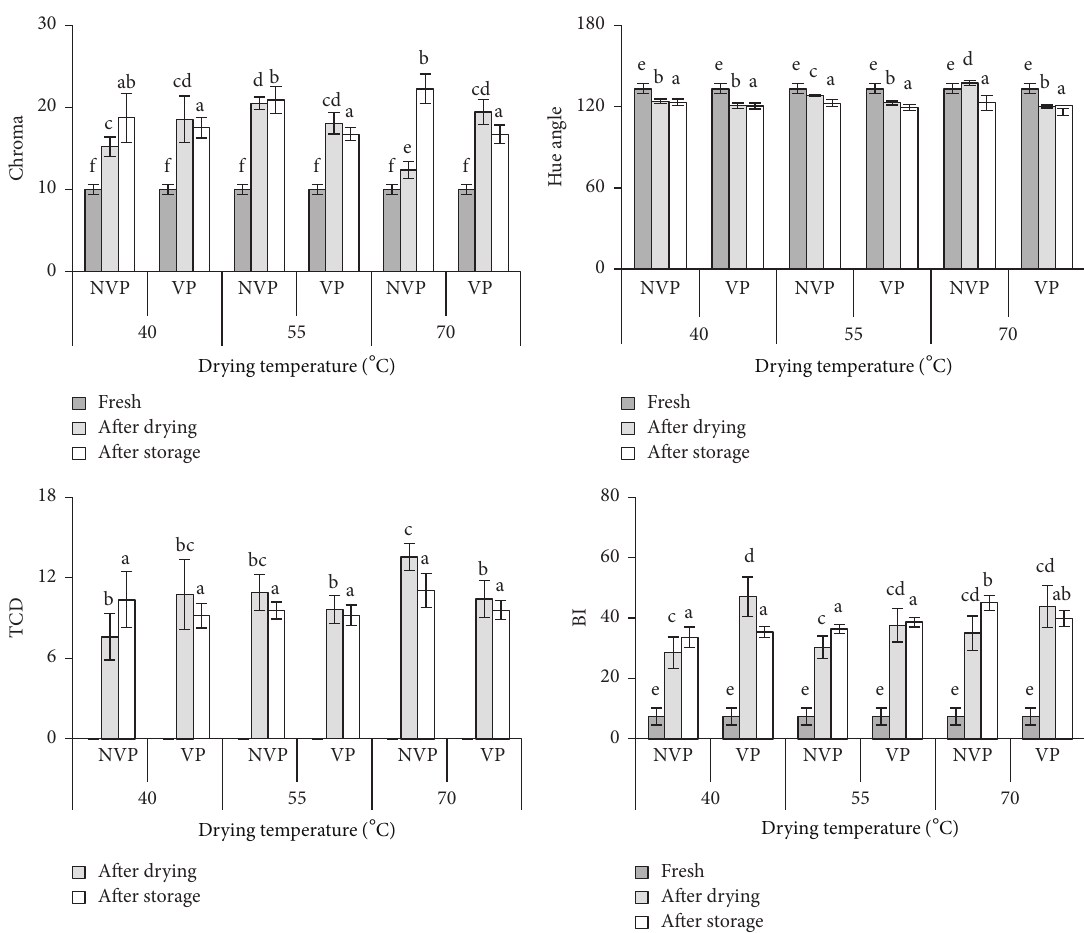
Figure 3: Average values of chroma, hue angle, total colour difference (TCD), and browning index (BI), obtained for galega kale that is fresh and dried at 40, 55, and 70 ∘ C packed with vacuum (VP) and without vacuum (NVP), after 1 week (after drying) and 20 weeks (after storage) of storage. Values with the same letter were not significantly different ( 𝑝 > 0.05 ). Bars are limits of standard deviation.